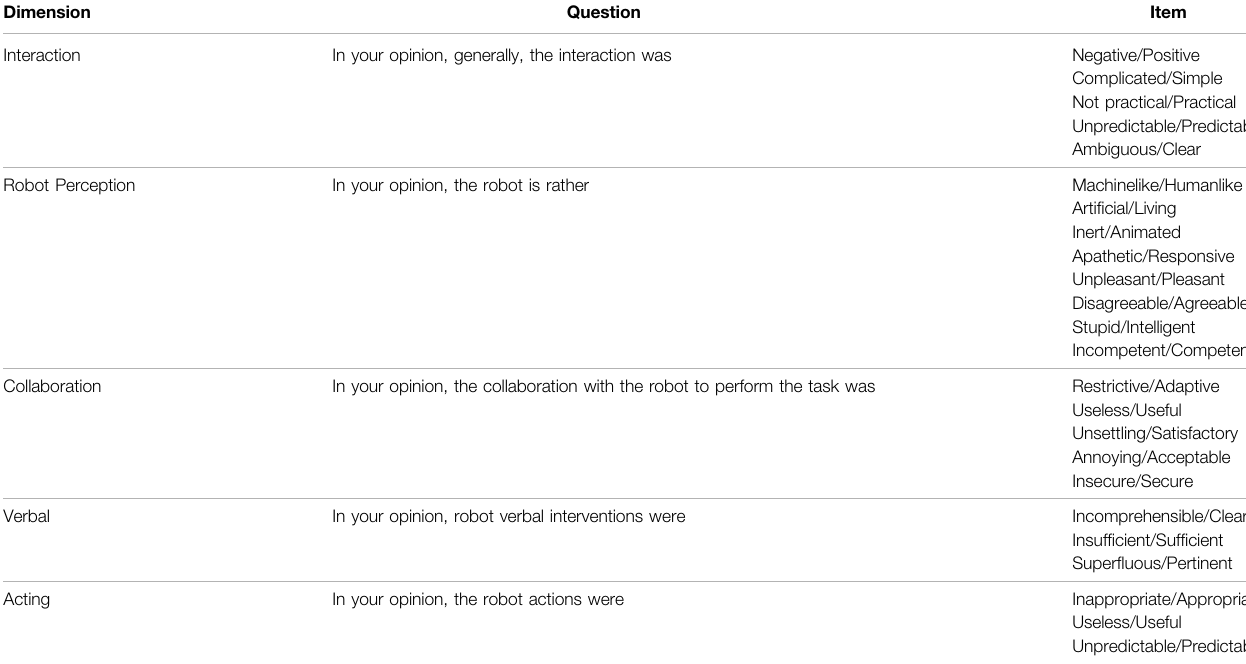
TABLE 1 | PeRDITA Questionnaire: Questions describing each dimension. Items are evaluated in a scale of 100.